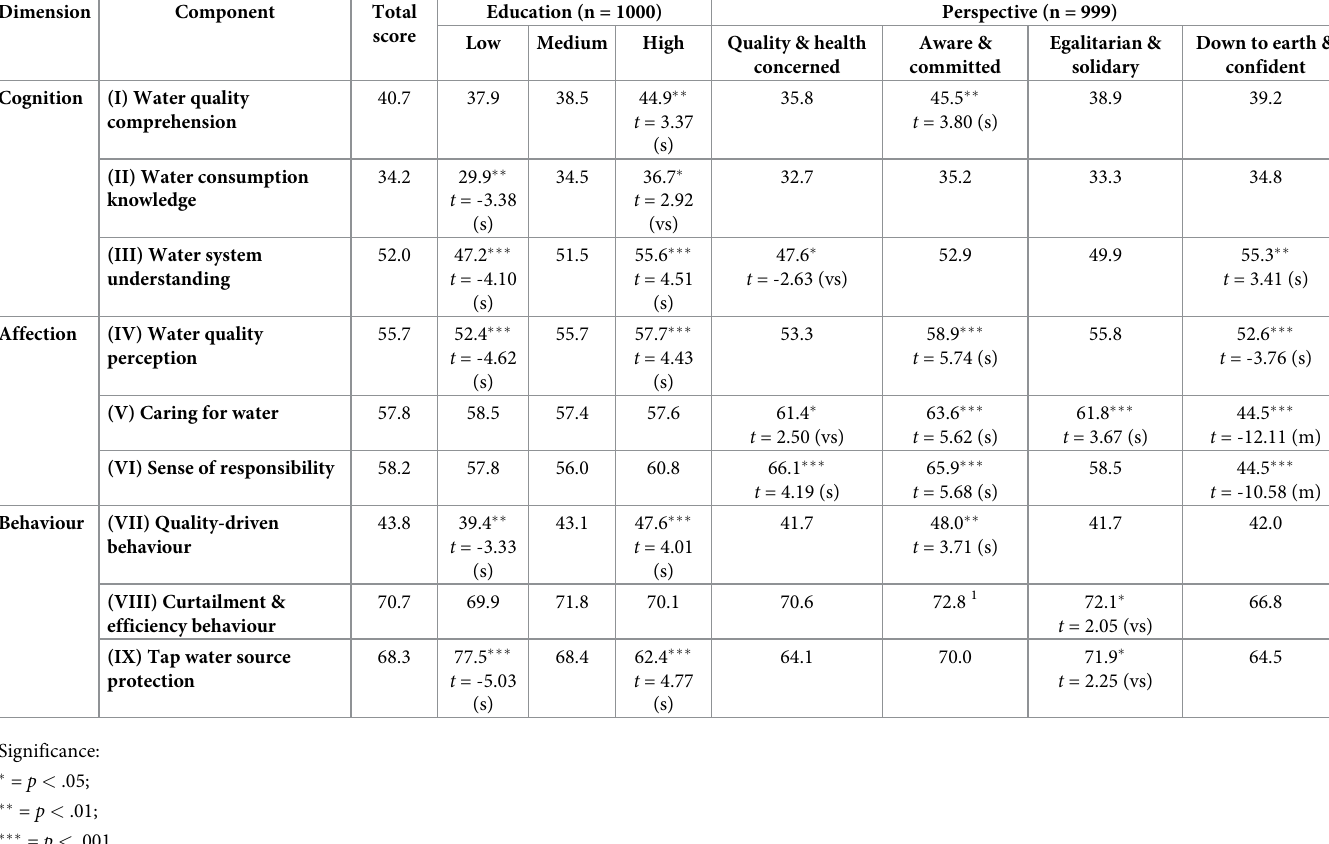
Table 6. Customer component awareness scores—Education and perspective.